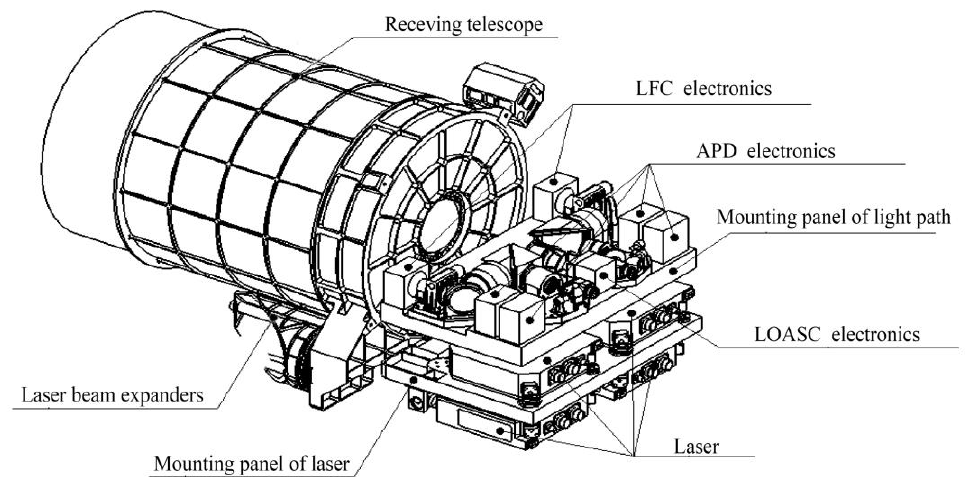
Figure 1. Main diagram of the GF-7 laser altimeter